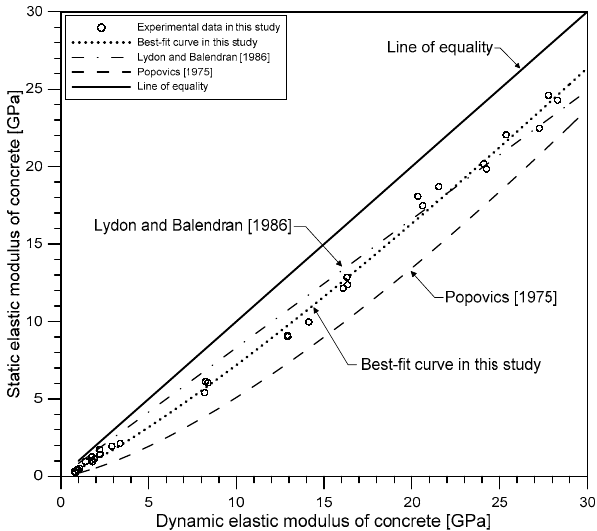
Figure 12. The relationship between static and dynamic elastic moduli of heat-damaged concrete.